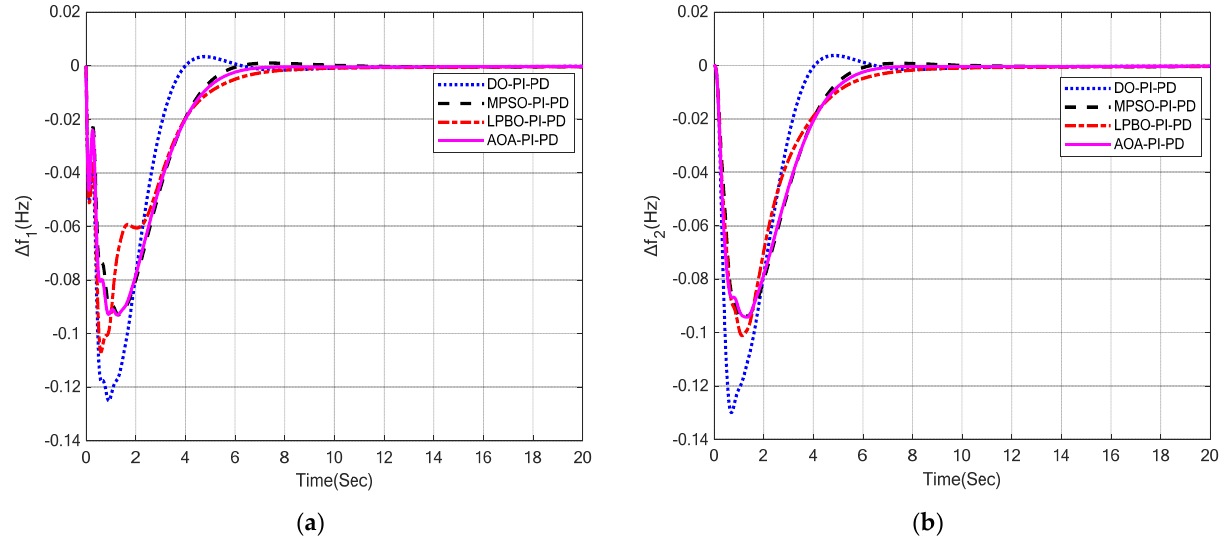
Figure 6. LFC responses in a two-area multi-source IPS with nonlinearities.( a ) ∆ f 1 ;( b ) ∆ f 2 .